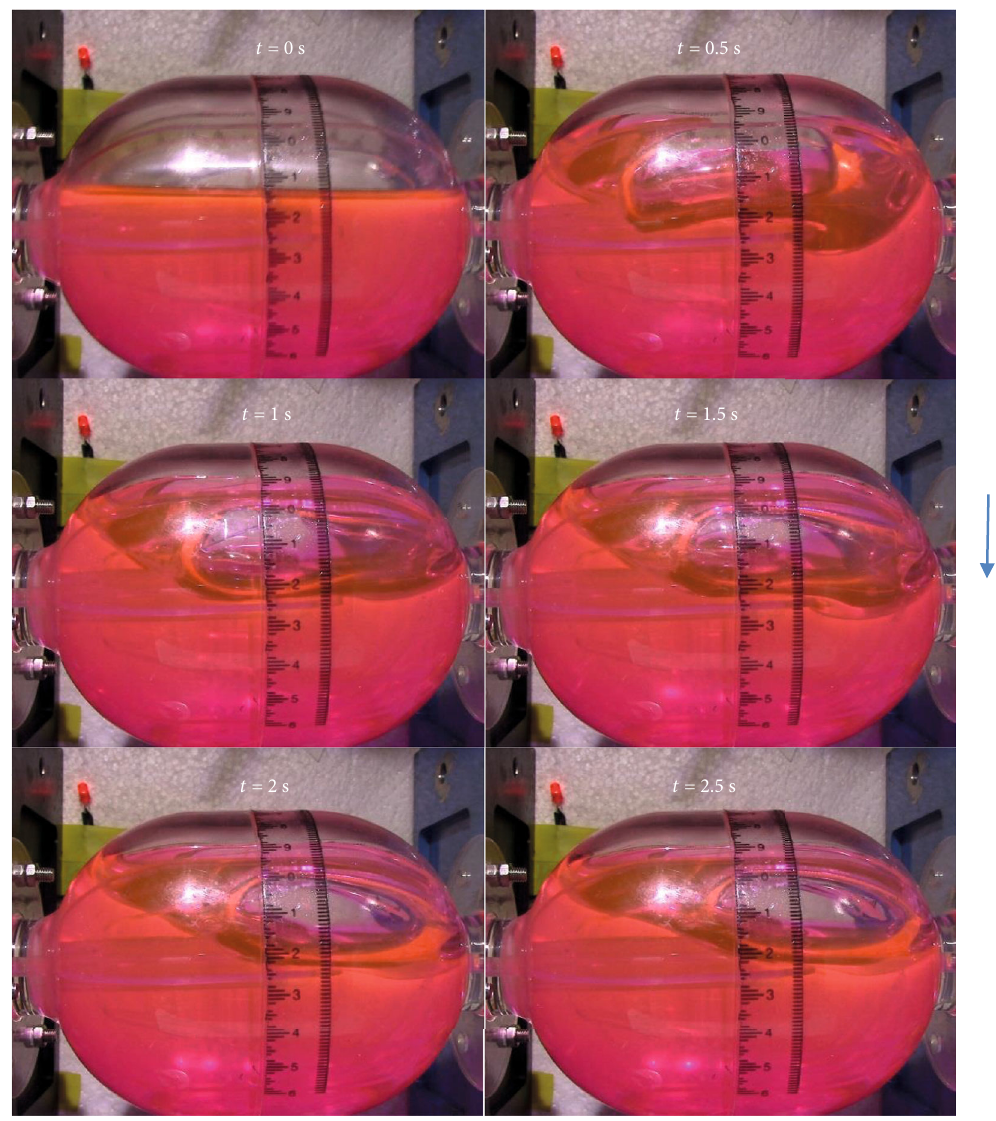
Figure 14: Liquid volume fraction is